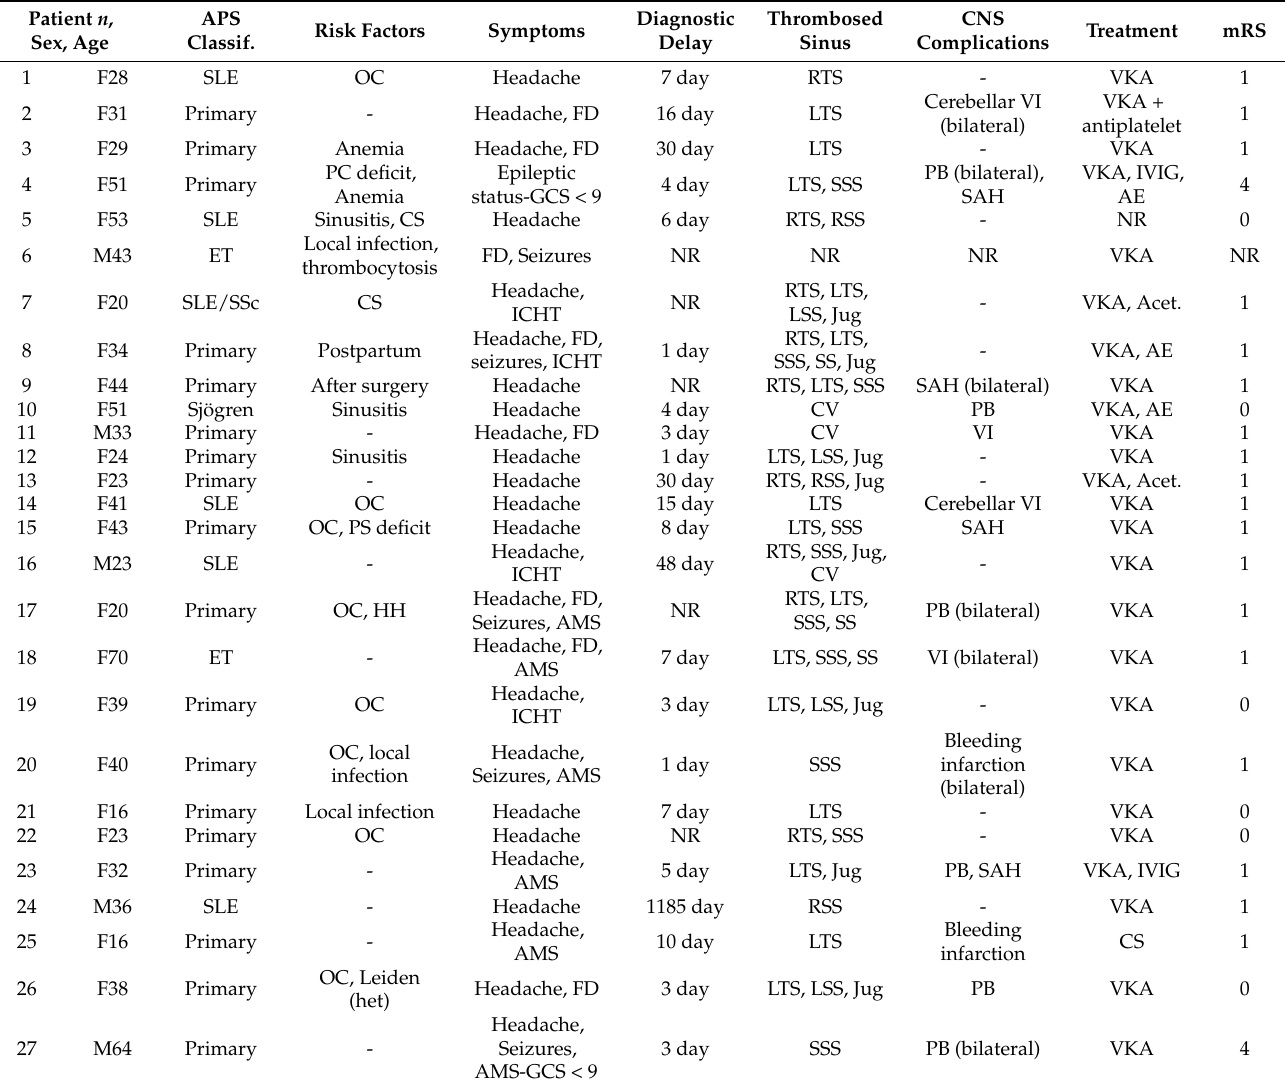
Table 2. CVT characteristics. This table gathers the main information about the characteristics of the CVT, the initial treatment used and the clinical status at discharge, evaluated by mRS. Abbreviations: OC, oral contraceptives; PC deficit, protein C deficit; CS, corticosteroids; PS deficit, protein S deficit; HH, hyperhomocysteinemia; Leiden (het), heterozygous factor V Leiden mutation; NR, not reported; FD, focal deficit; ICHT, intracranial hypertension; AMS, altered mental status; GCS, Glasgow Coma Scale; RTS, right transverse sinus; LTS, left transverse sinus; SSS, superior sagittal sinus; SS, straight sinus; RSS, right sigmoid sinus; LSS, left sigmoid sinus; Jug, jugular vein; CV, cortical veins; VI, venous infarction; PB, parenchymal bleeding; SAH, subarachnoid hemorrhage; VKA, vitamin K antagonists; IVIG, intravenous immunoglobulins; AE, antiepileptic treatment; Acet.,